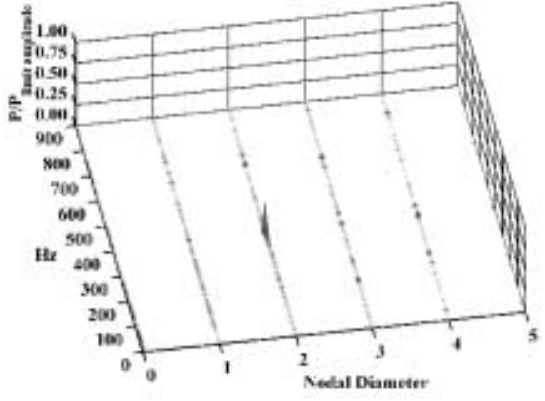
Fig. 15. Two-dimensional Fourier transform of pressure transducer data at 11 seconds.